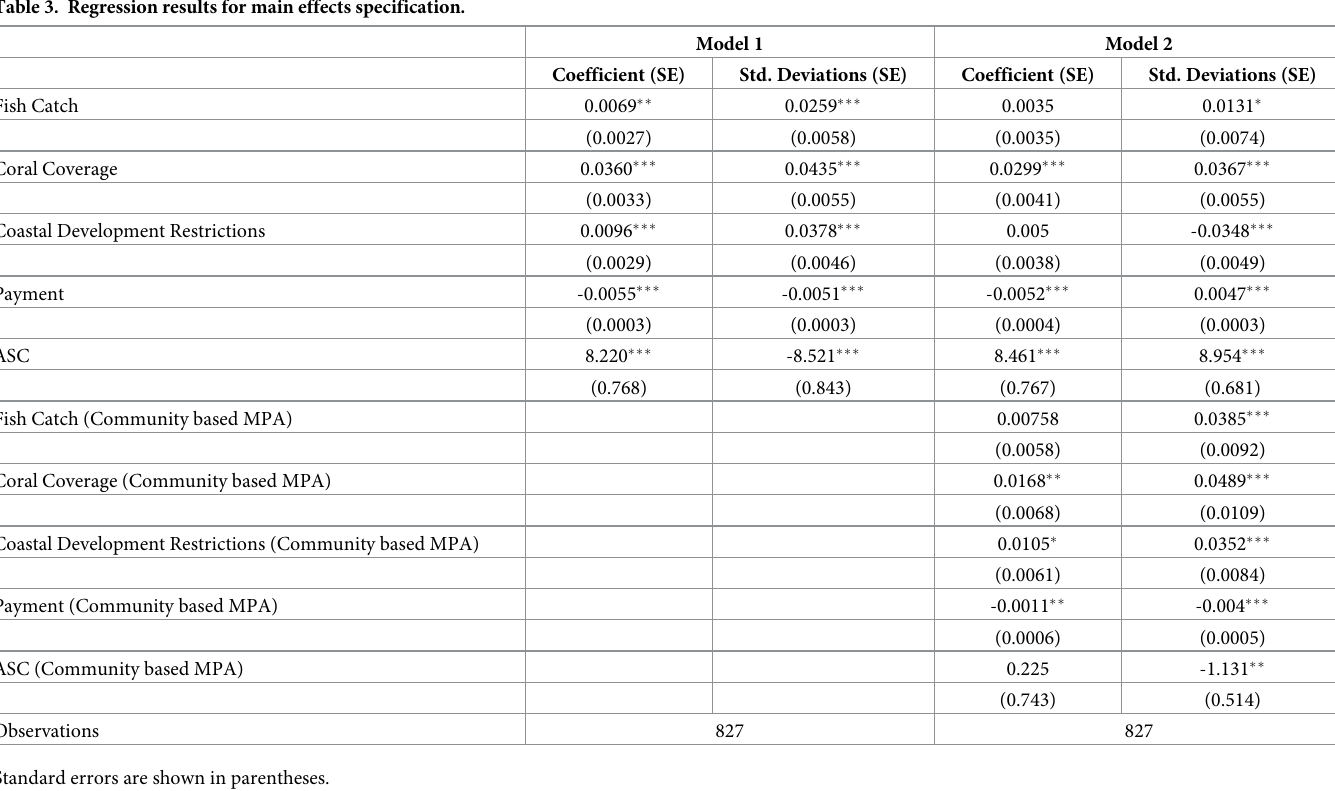
Table 3. Regression results for main effects